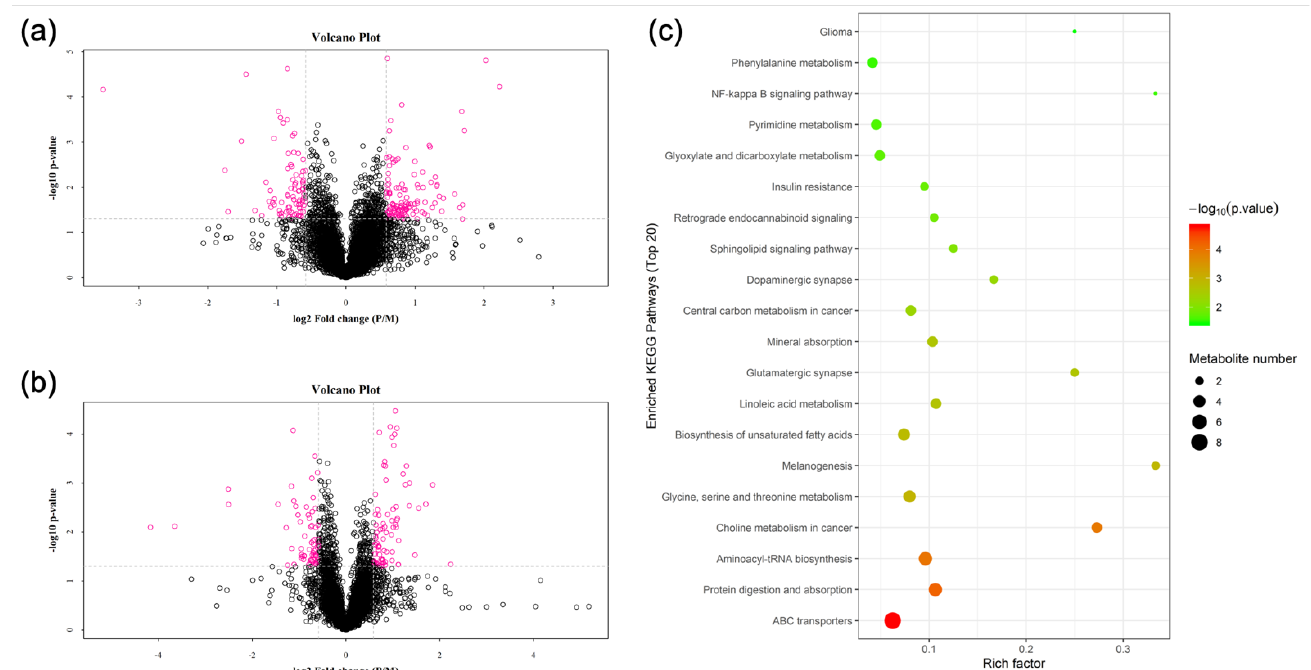
Figure 2. Metabolomics. ( a ) Positive ion mode differential metabolites; ( b ) negative ion mode differential metabolites; ( c ) significant KEGG pathway.